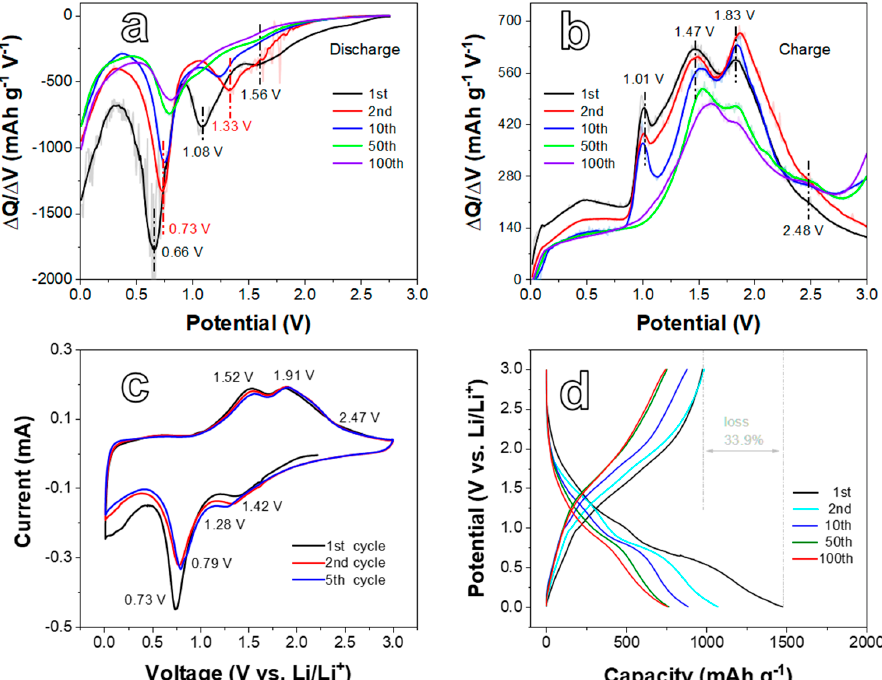
Figure 4. The differential capacity plots of the D5 electrode in the process of ( a ) Discharge and ( b ) Charge at the current density (CD) of 200 mA g − 1 . ( c ) CV curves of the D5 electrode at a scan rate of 0.1 mV s − 1 in the voltage range from 0.01 to 3.0 V. ( d ) Galvanostatic charge/discharge profiles of the D5 electrode at the CD of 200 mA g − 1 .